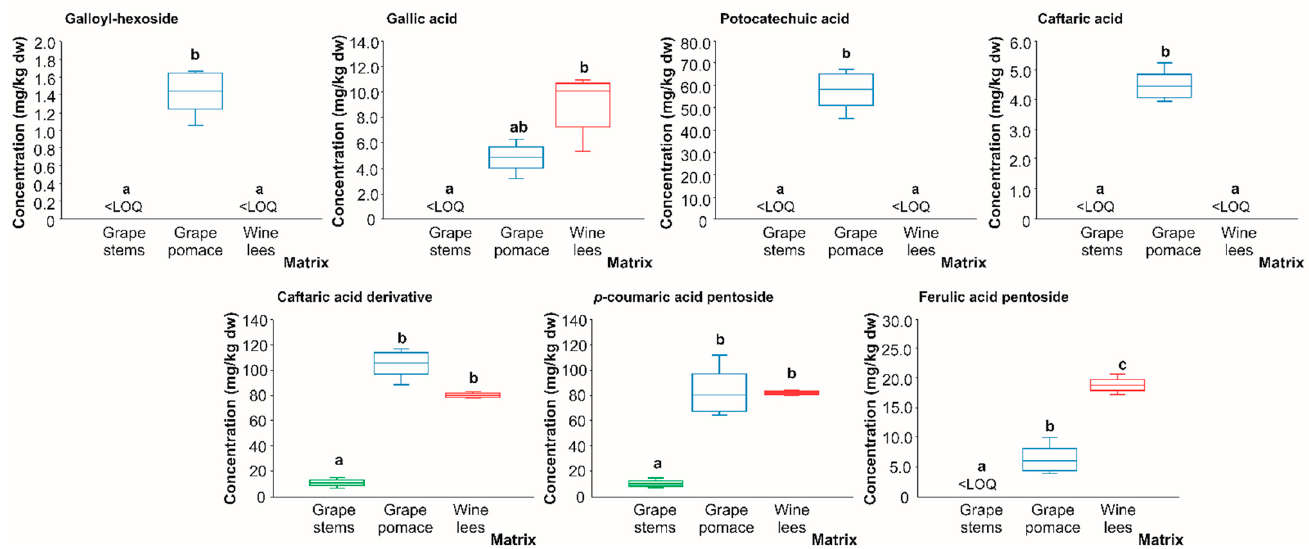
Figure 7. Box plots with quartiles (upper values 75%, median 50%, and lower values 25%) of individual phenolic acids (mg/kg dw) of (poly)phenolic extracts of grape stems (green box), grape pomace (blue box), and wine lees (red box). Boxes with a different letter (a,b,c) within each plot indicate statistically significant differences ( p < 0.05) according to the one-way analysis of variance (ANOVA) and Tukey’s multiple range test. <LOQ, lower than the limit of quantification.